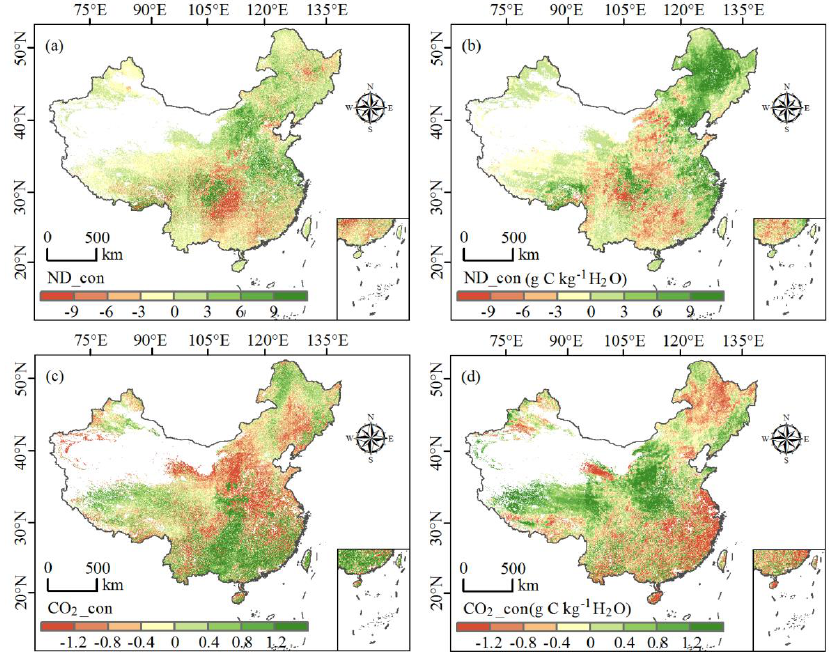
Figure 5. Contribution of ND and CO 2 to CUE and WUE. ( a , b ) Contribution of ND to CUE and WUE, ( c , d ) Contribution of CO 2 to CUE and WUE.